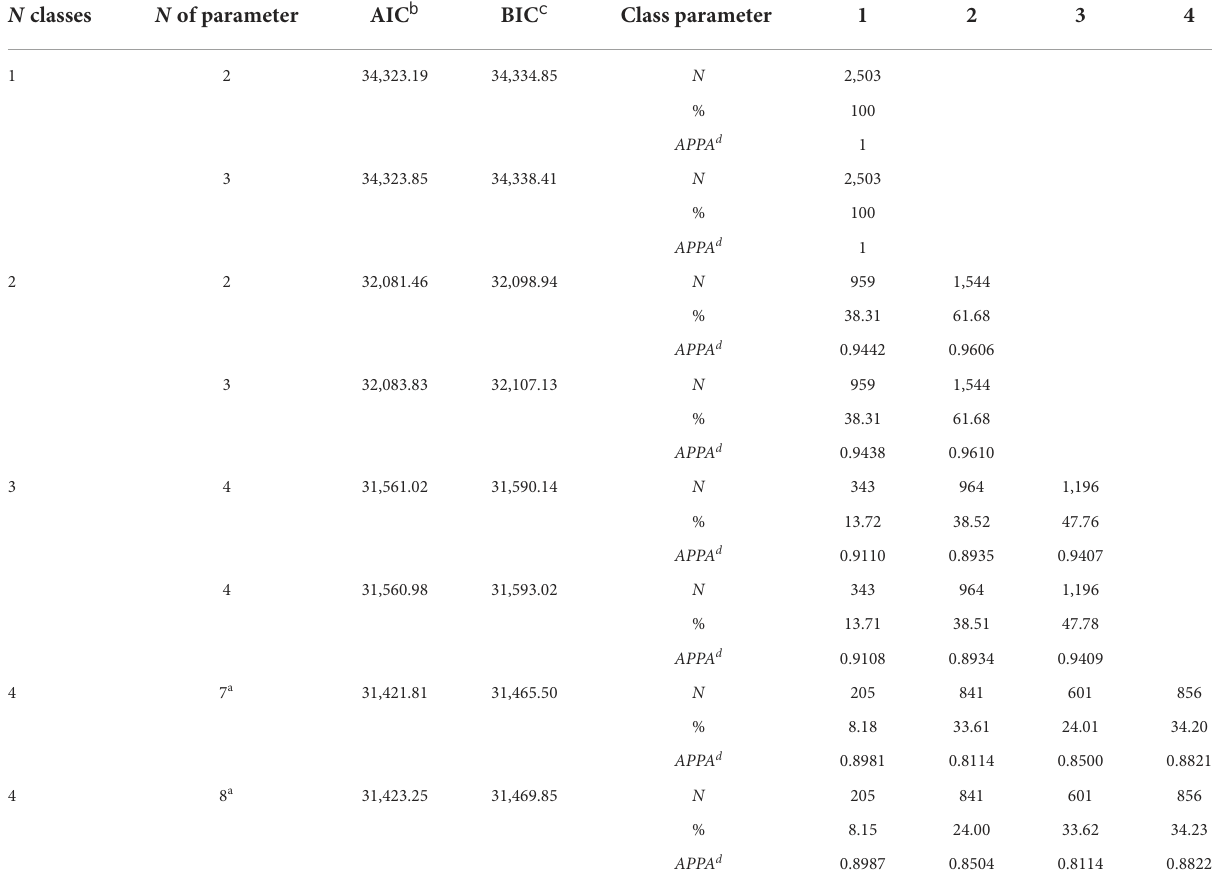
a Preferredmodel. b Akaikeinformationcriterion. c Bayesianinformationcriterion. d Averageposteriorprobabilityofassignment.